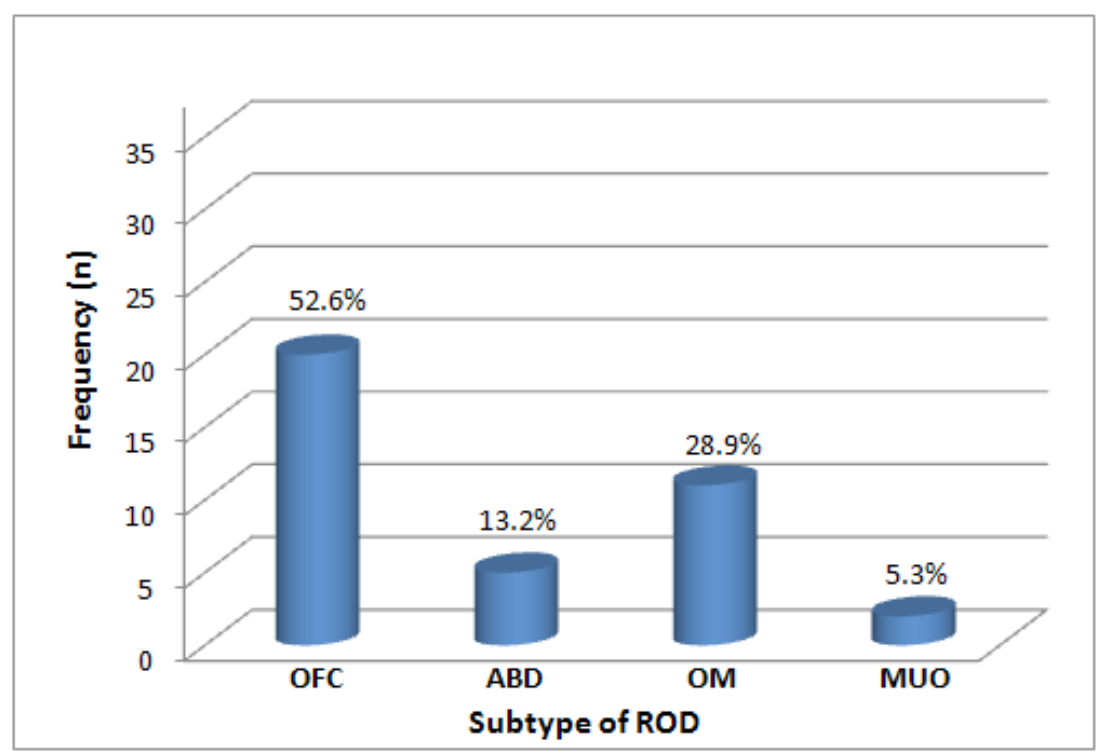
Figure 1 . Frequency distribution of the subtypes of ROD among patients with